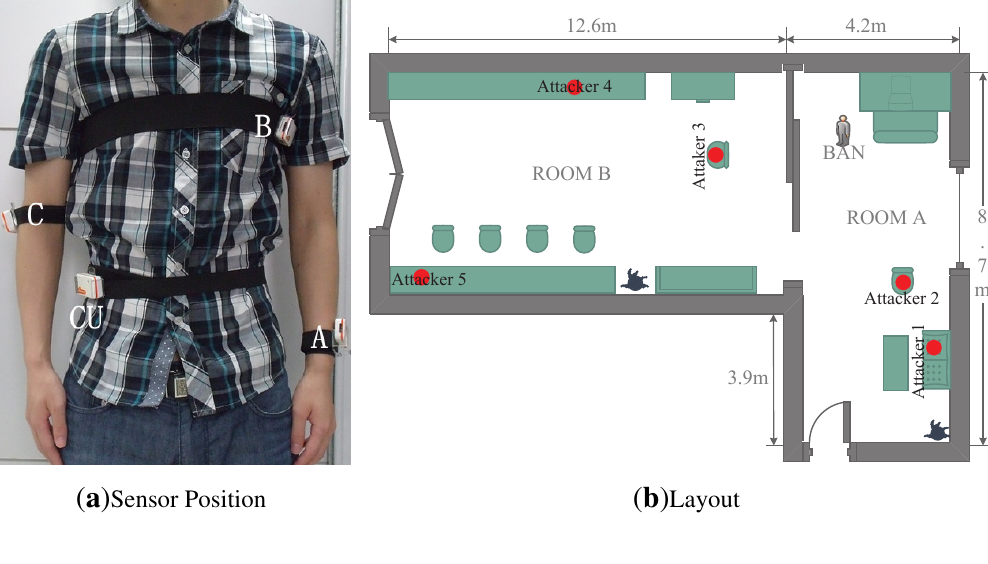
Figure 6. Sensor placement on the human body and layout for experiments.